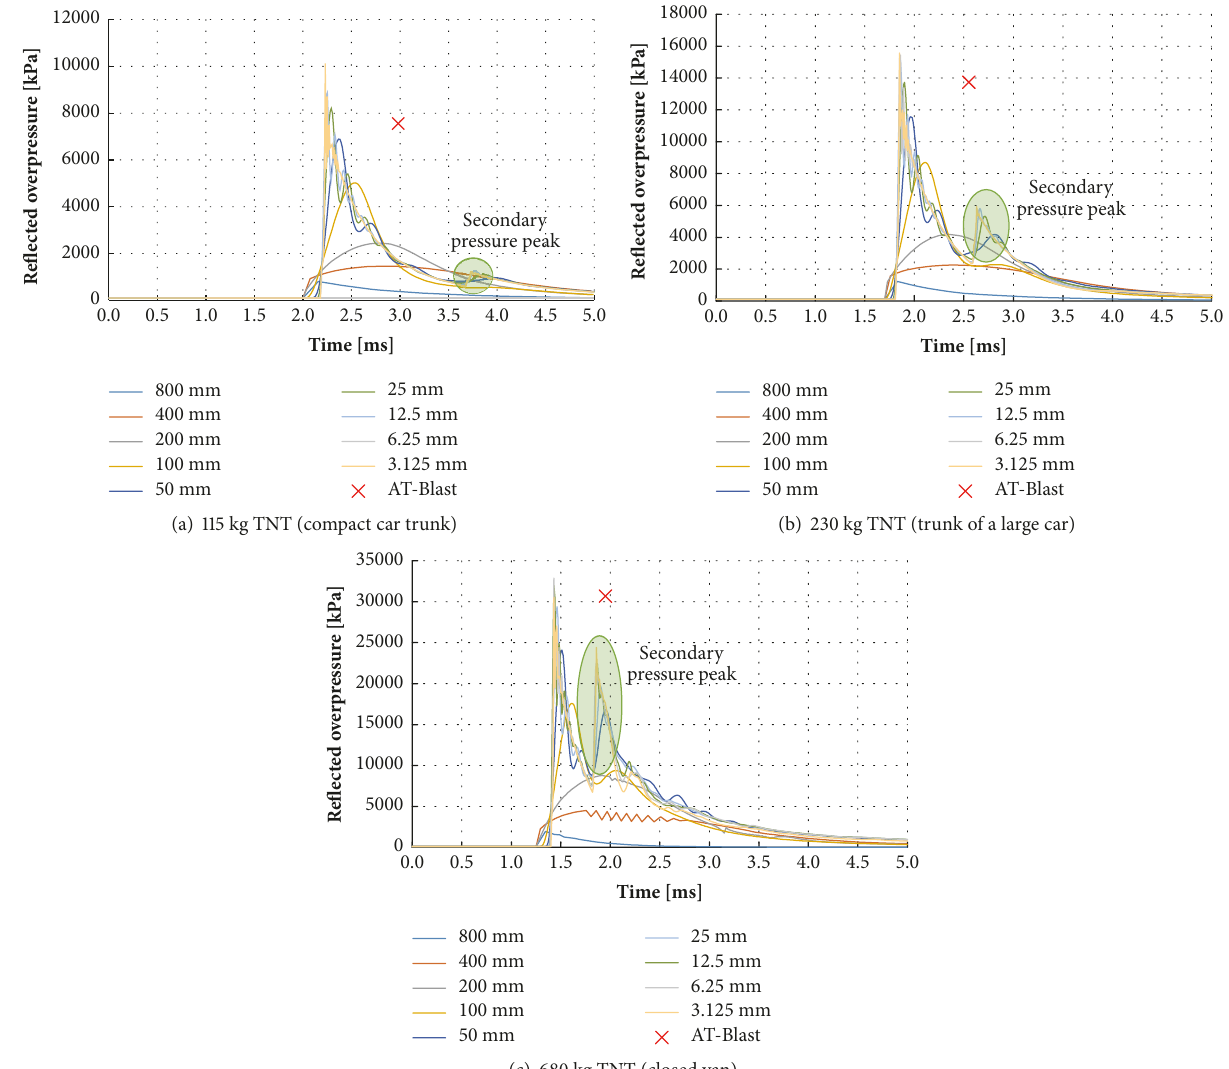
Figure 6: Reflected pressure-time histories.